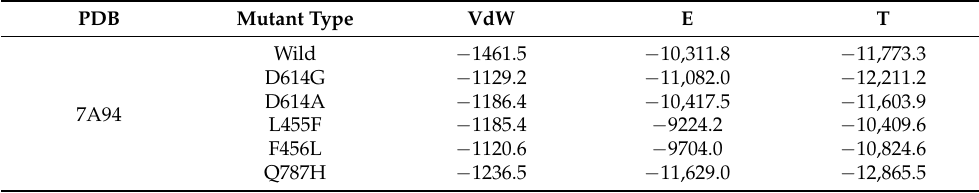
Figure 5. MM/PBSA result depending on the MD trajectories in the 1-open-complex form (7A94). ( a ) Wild type, ( b ) D614G, ( c ) D614A, ( d ) L455F, ( e ) F456L, and ( f ) Q787H. The X axis denotes trajectory (ps), and the Y axis denotes MM/PBSA energy value (kJ/mol). Blue color indicates van der Waals energy between S protein and ACE2, orange color indicates electrostatic energy, and gray color indicates total energy. Table 2. Summary of MM/PBSA between the S protein and ACE2 in the 1-open-complex form. VdW indicates van der Waals energy, E denotes electrostatic energy, and T is total energy (kJ/mol). The values were measured in the final trajectory (10